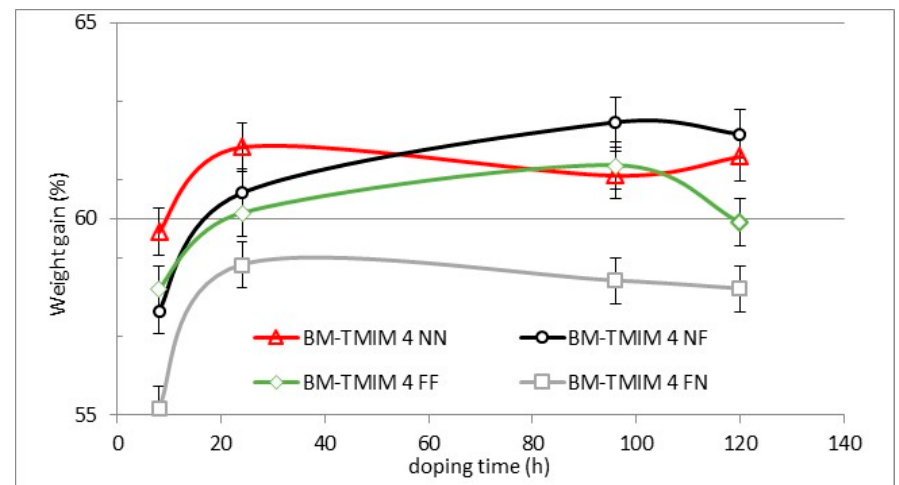
Figure 5. Acid uptake of blend membranes doped in a 30% sulfuric acid solution as a function of time.